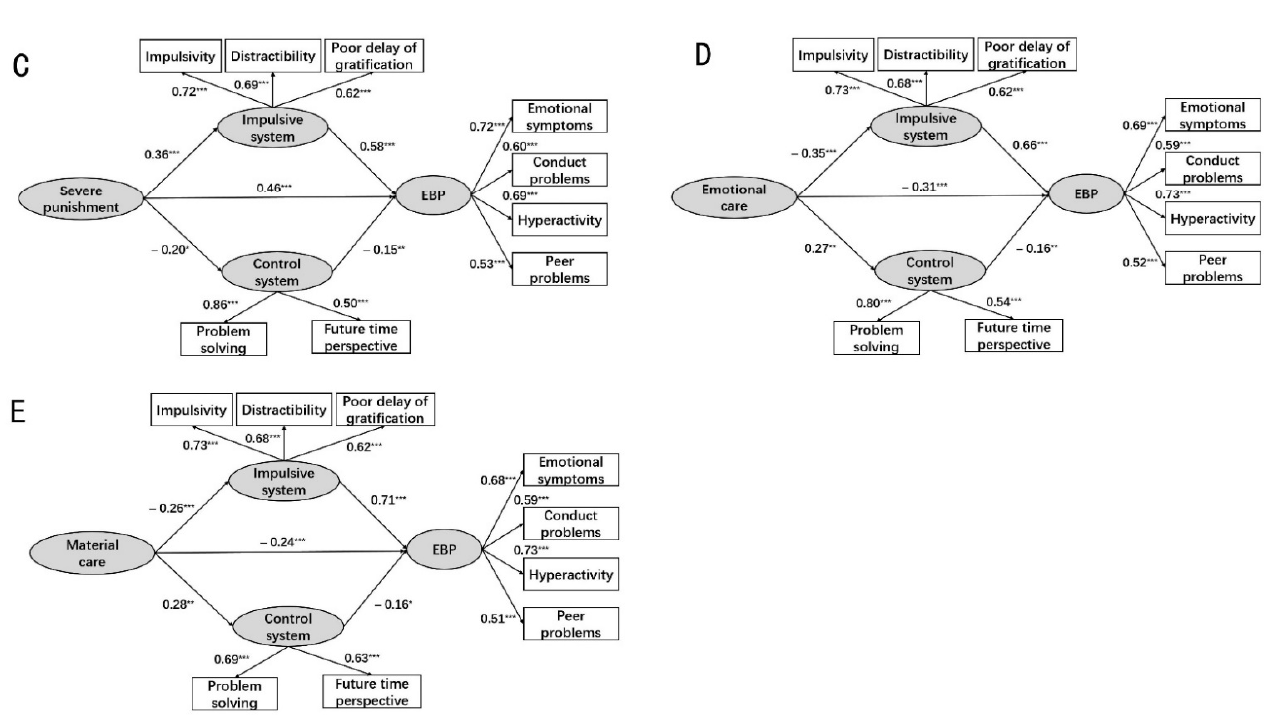
Figure 2. The mediating effects model for impulsive system and control system. ( A – E ) show the effects of rejection, partiality, severe punishment, emotional care and material care on EBP, respectively. Standardized path coefficients ( β ) are presented. Note: *: p < 0.05; **: p < 0.01; ***: p < 0.001. Table 3. Results of multiple mediating